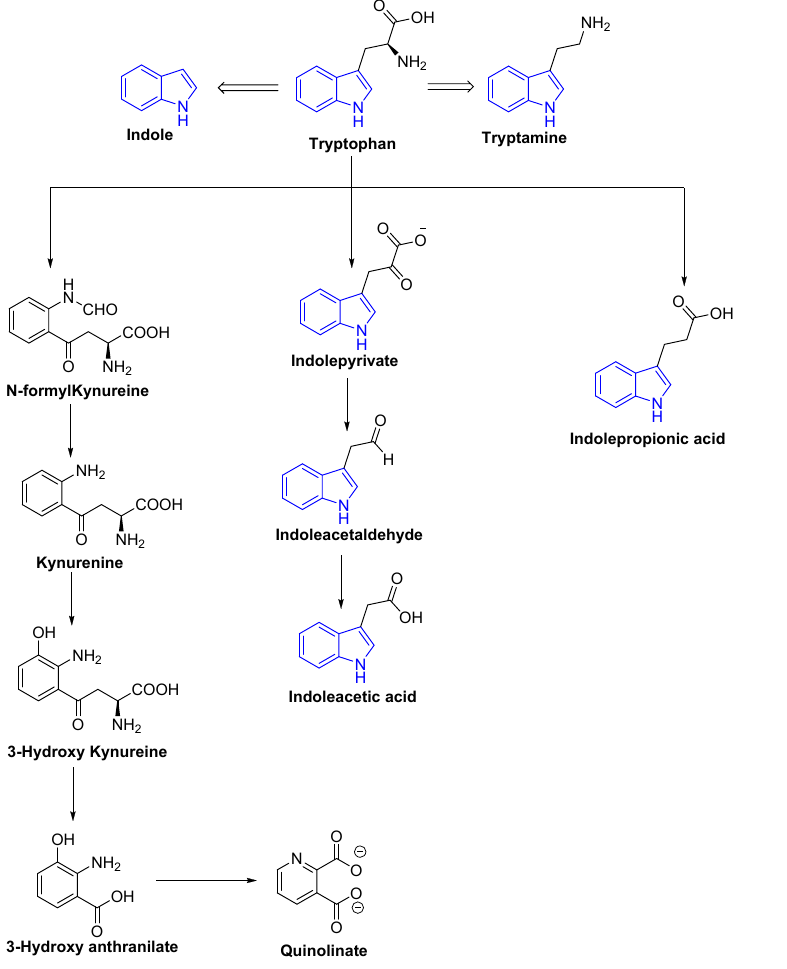
Figure 4. Schematic representation of tryptophan metabolism pathway leading to the production of neuroactive compounds.